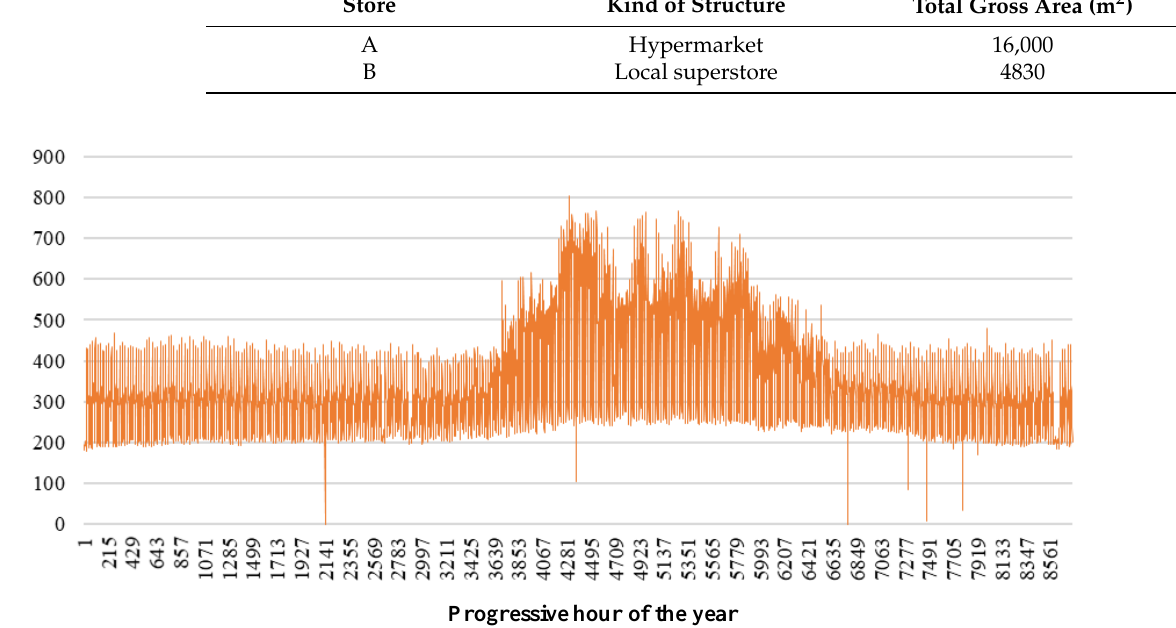
Table 4. Main geometrical data about the two stores under analysis.